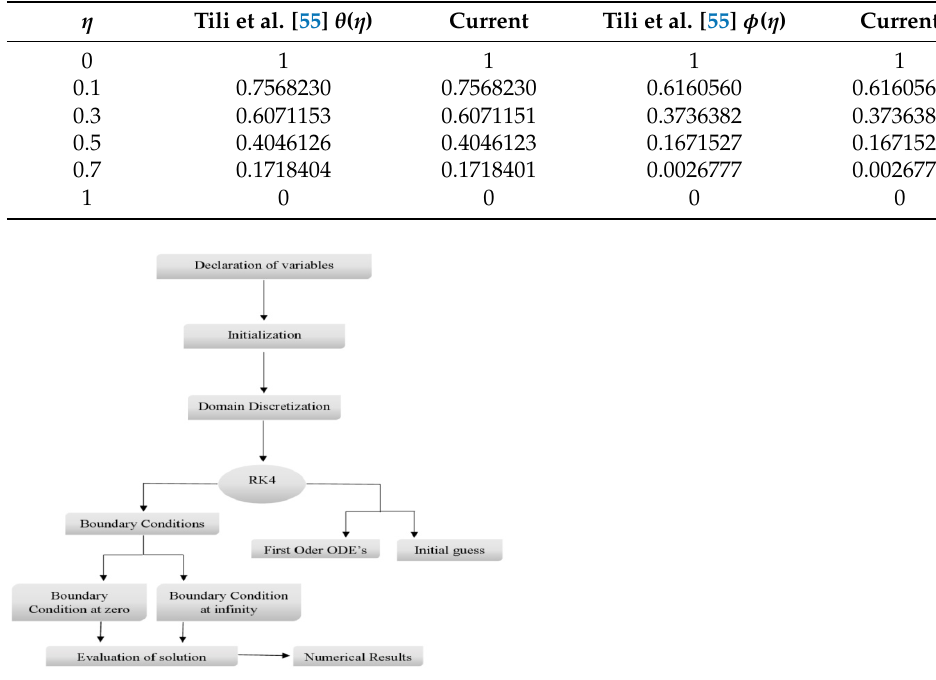
Figure 2. Flow chart of RK4 method. Table 1. Validation of the present work with published work for temperature and concentration profiles.